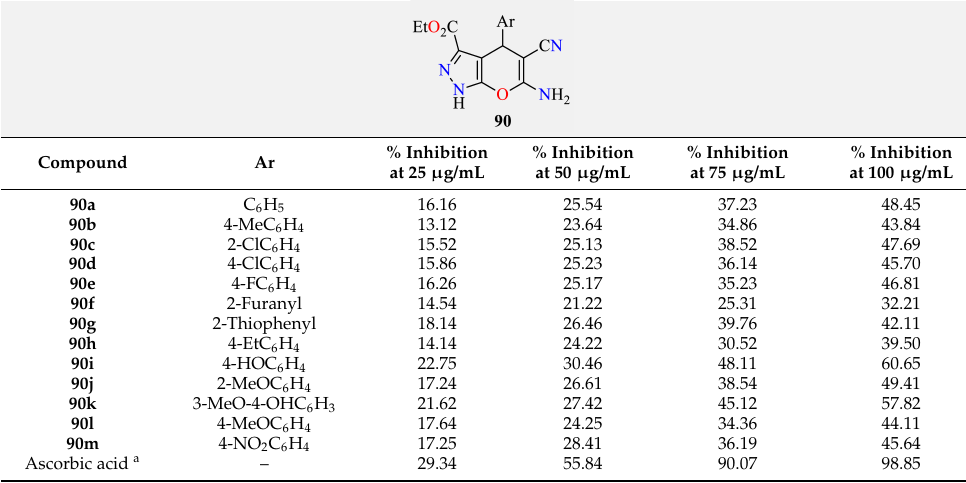
Table 44. Antioxidant activity of dihydropyrano[2,3- c ]pyrazole derivatives 90